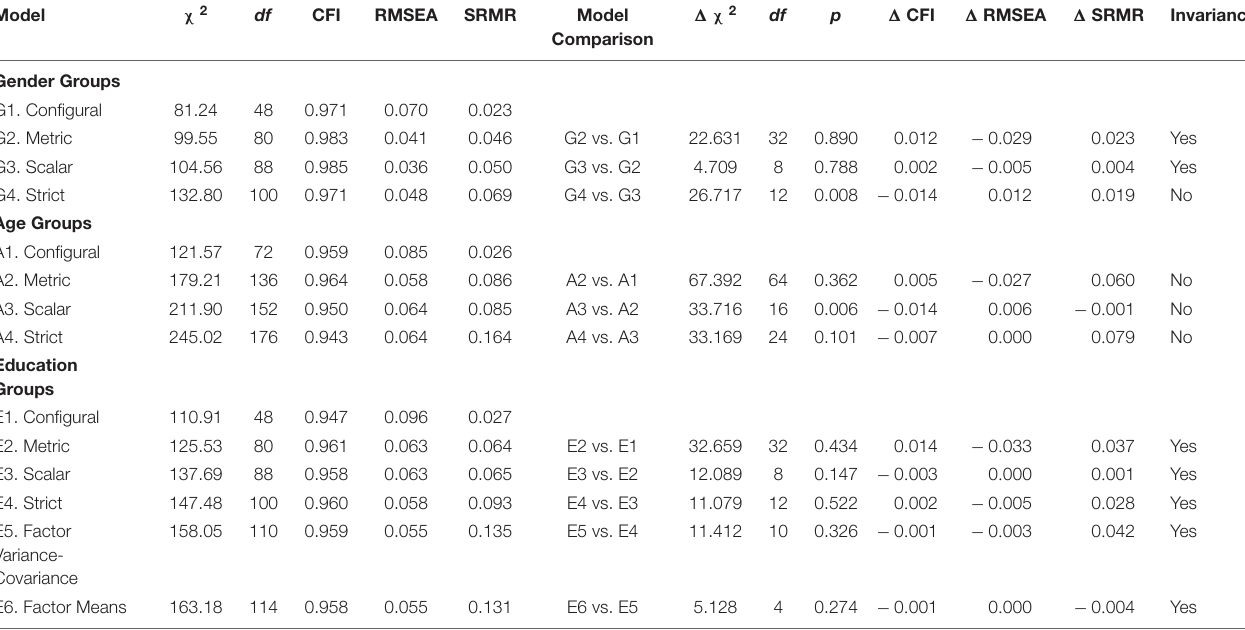
TABLE 6 | Measurement invariance for the final retained model (four-factor first-order ESEM, Model 4). Model χ